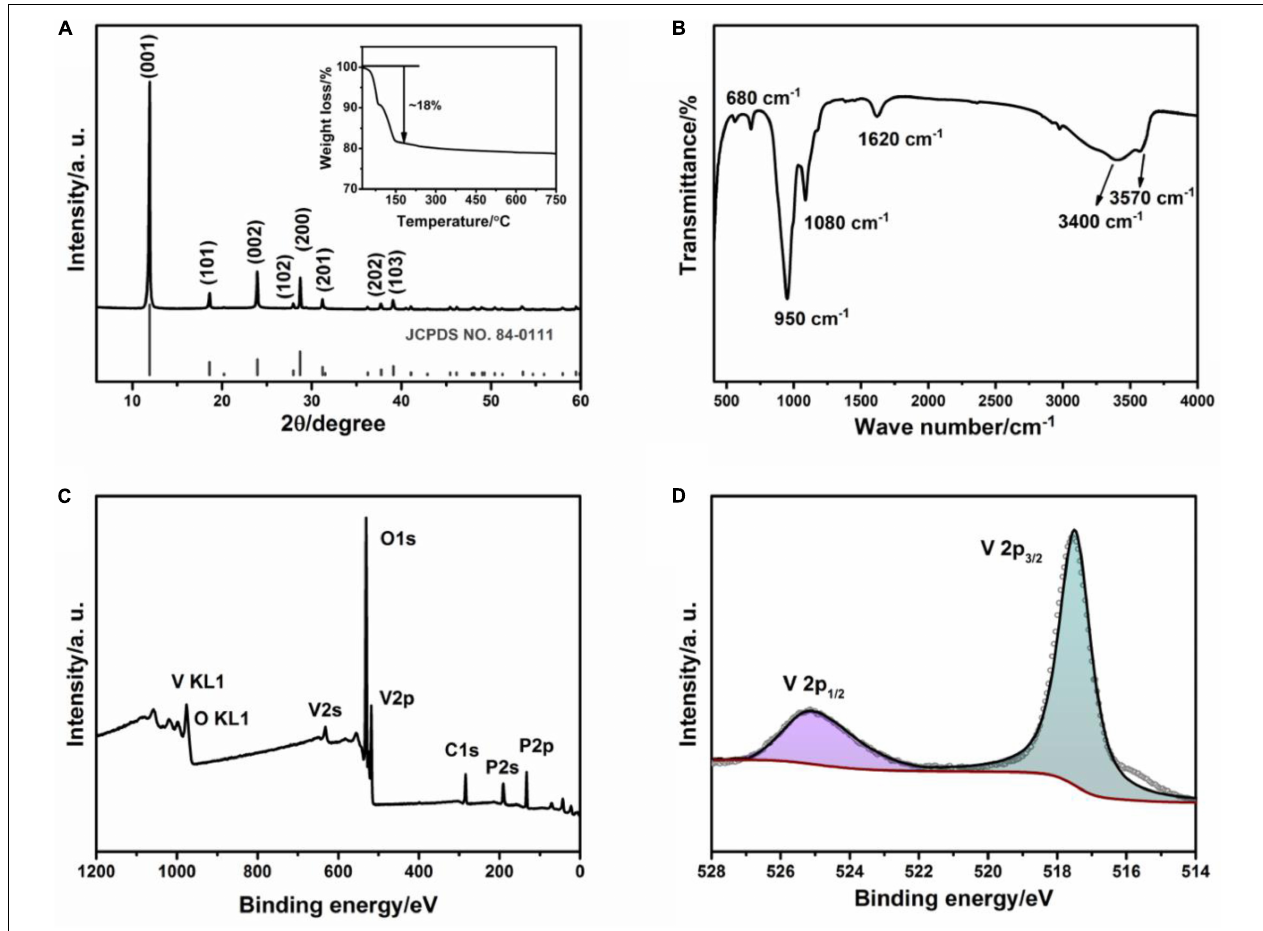
FIGURE 1 | (A) XRD pattern and TG curve (inset); (B) FT-IR spectrogram; (C) XPS spectrum; (D) Core-level XPS spectrum of V2p of the sample prepared by a reflux